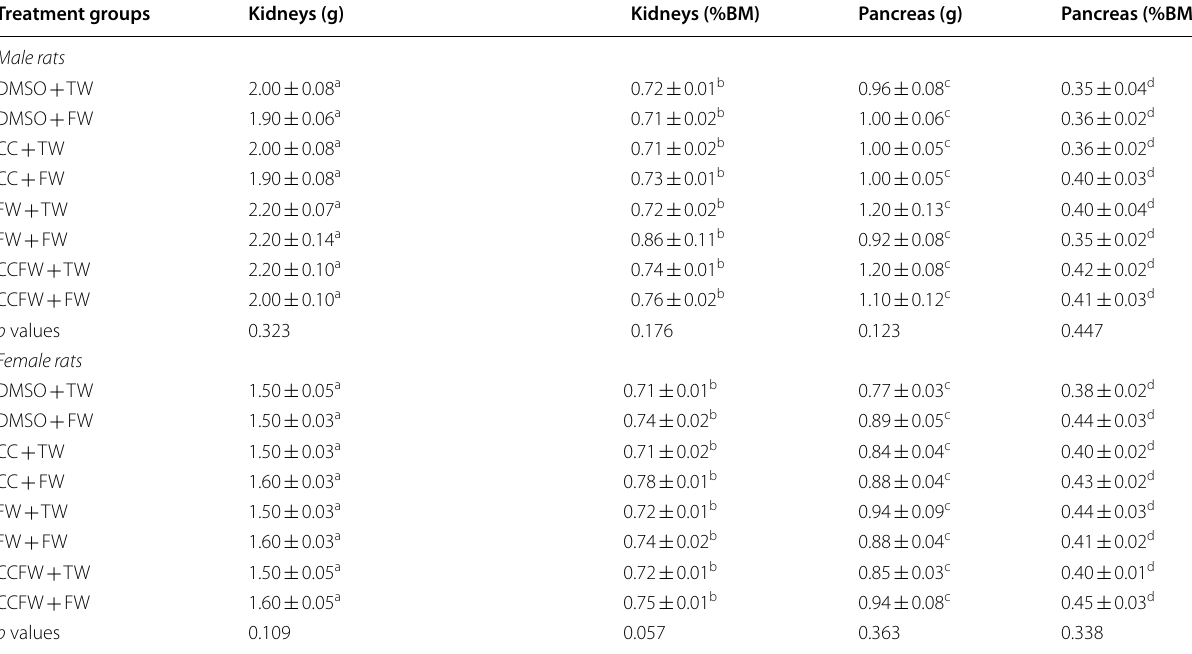
a, b, c, d Means across columns (in males and females) with similar superscripts are similar ( p > 0.05) using one-way ANOVA across all eight groups for the masses of the viscera.